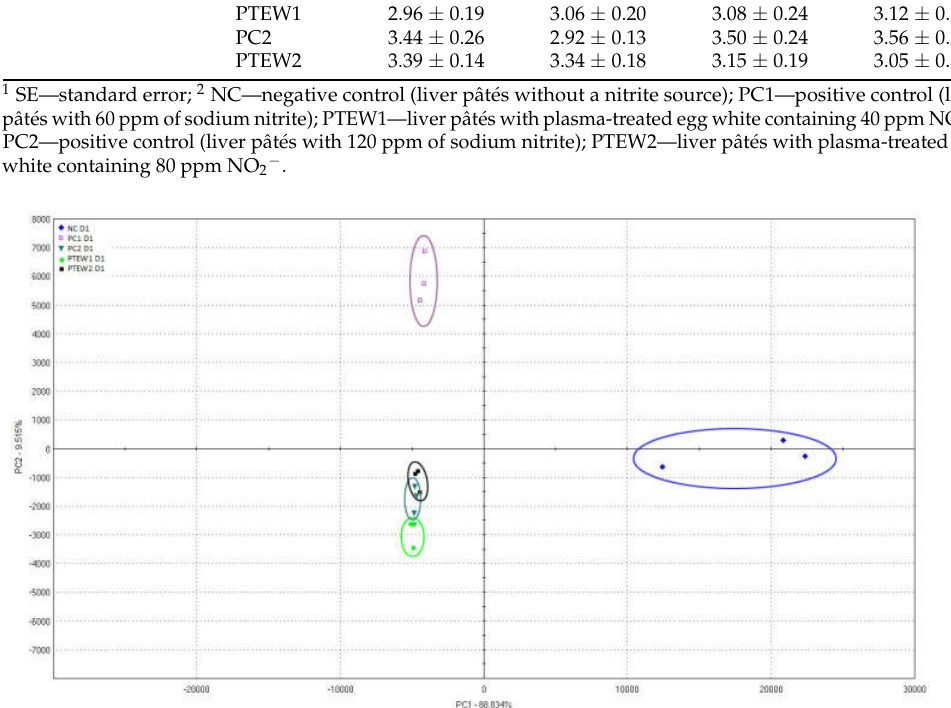
Figure 3. Principal component analysis of liver pâtés—day 1;NC—negative control (liver pâtés without a nitrite source); PC1—positive control (liver pâtés with 60 ppm of sodium nitrite); PTEW1— liver pâtés with plasma-treated egg white containing 40 ppm NO 2− ; PC2—positive control (liver pâtés with 120 ppm of sodium nitrite); PTEW2—liver pâtés with plasma-treated egg white containing 80 ppm NO 2− .